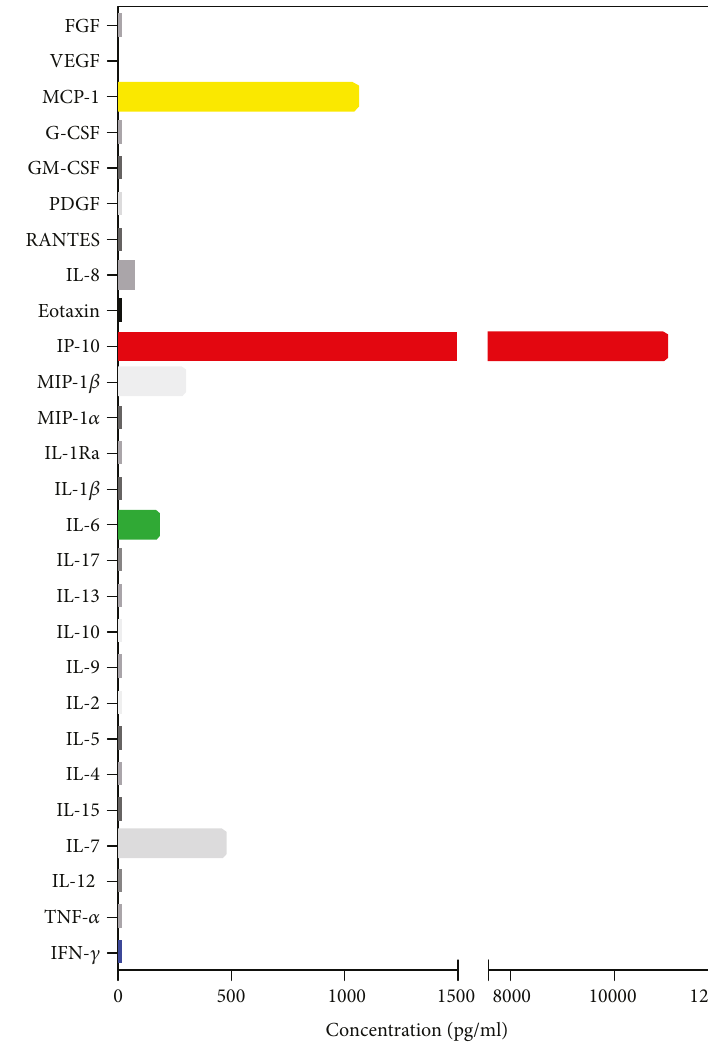
Figure 5: Bar chart showing the pattern of immune mediators in aqueous humor of a patient who had 18 recurrences with generally low immune mediator levels in aqueous humor and elevated levels of IP-10, and concentrations of MCP-1, MIP-1 β , IL-7, and IL-6 are